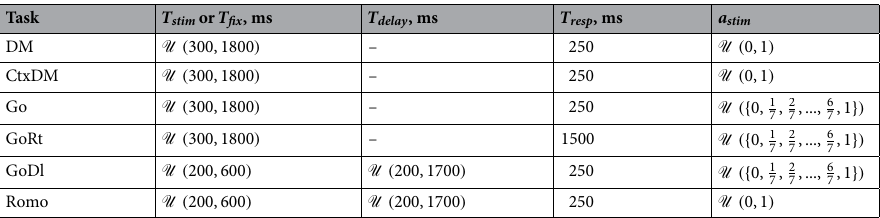
Table 2. Parameters of the target cognitive tasks. The term U ( a , b ) indicates the continuous uniform distribution of a random variable from a to b , and U ( { a 1 , a 2 , . . . , a n } ) denotes the discrete uniform distribution of variables a i , i = 1, . . . , n